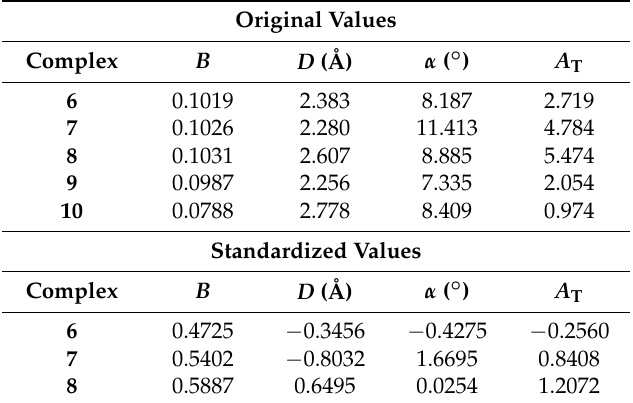
Table 4. The original and standardized values of bond order ( B ), minimum distance ( D ) and dihedral angle ( α ) for complexes 6 – 10 .